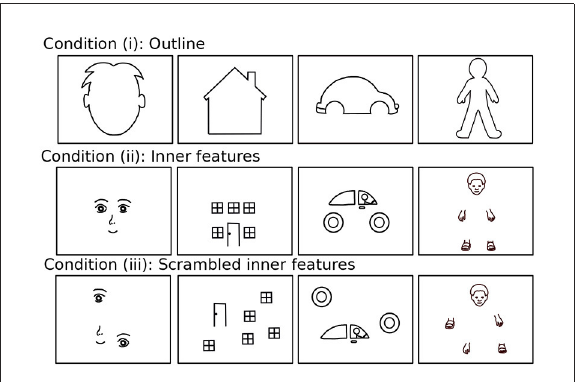
FIGURE1 The twelve stimuli of which six were presented to each of the children, consisting of four different stimuli categories (face, house, car, and human figure) and three presentation conditions (outline, inner features, scrambled inner features). Reproduced with permission from Philippsen et al.